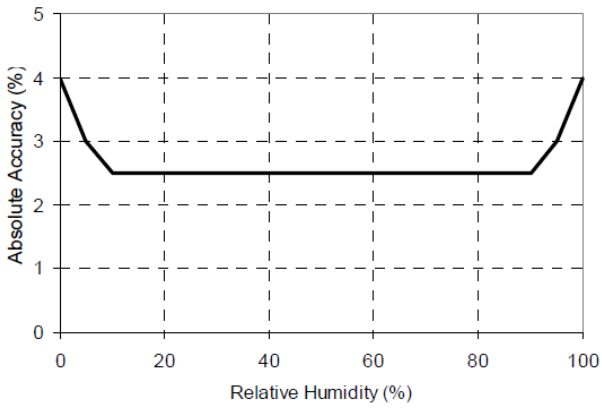
Figure A1. Humidity sensor accuracy plot (adopted from the specification of HOBO Pro v2).